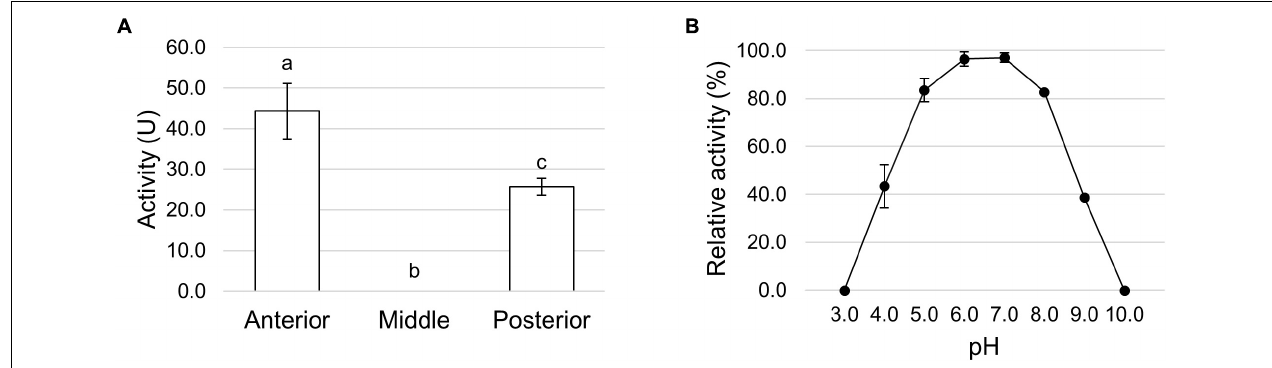
FIGURE 12 | α -amylase activity in the different midgut regions. (A) α -amylase activity in midgut juice extracted from anterior, middle, and posterior midgut. The values are reported as mean ± SEM of at least 3 experiments. Different letters denote significant differences (ANOVA test followed by Tukey’s test. ANOVA p -value < 0.001, Tukey’s test p -values: Middle vs. Anterior p < 0.001, Posterior vs. Anterior p < 0.05, Posterior vs. Middle p < 0.05). (B) Dependence of α -amylase activity on pH in midgut juice from the anterior region of the midgut. Relative activity values (%) are reported as mean ± SEM of at least 3 experiments and are expressed as percentage of the highest activity over the pH range examined.